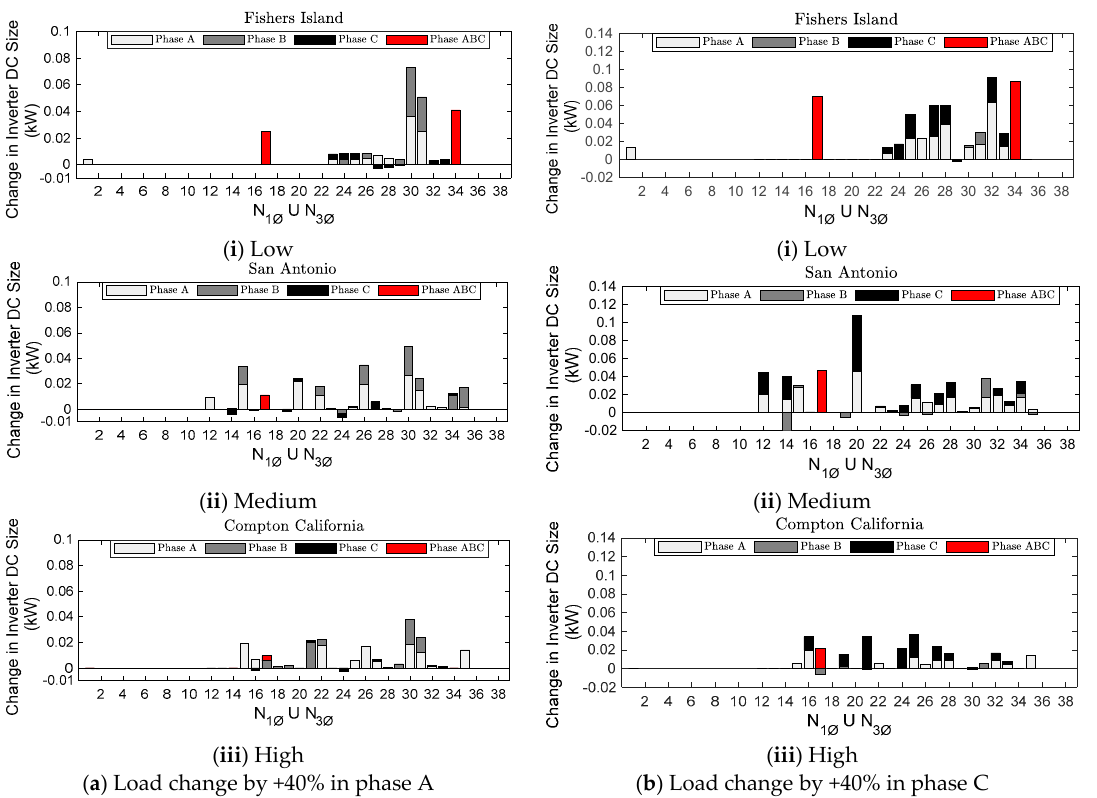
Figure 6. PV inverter placement and size with load change in one of the phases.